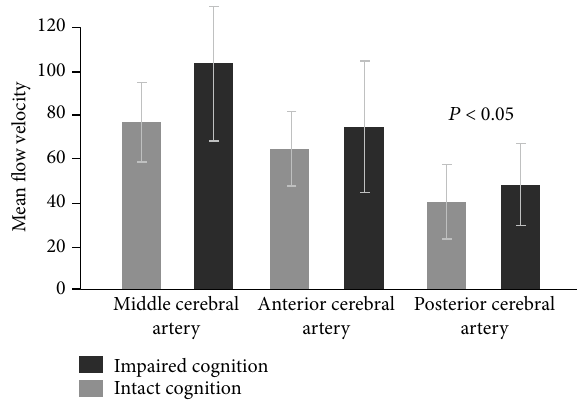
Figure 4: The average MFVs of the cerebral arteries measured within the fi rst 10 days in aSAH patients with cognitive impairment and aSAH patients with intact cognition. Table 5: Prediction of the cognitive impairment and binary logistic regression for MFV cut-o ff values measured by TCD.